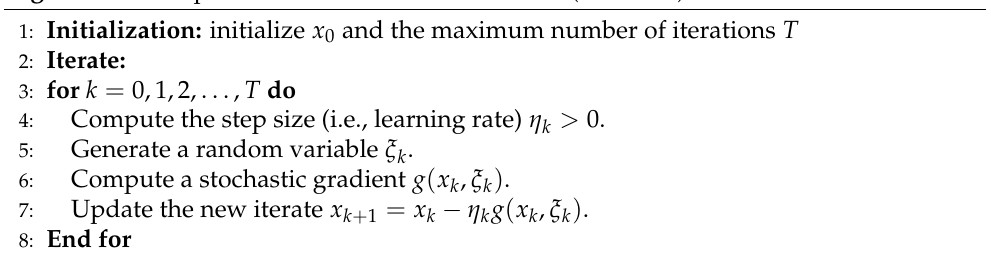
Algorithm 1 Adaptive Stochastic Gradient Descent (AdaSGD)